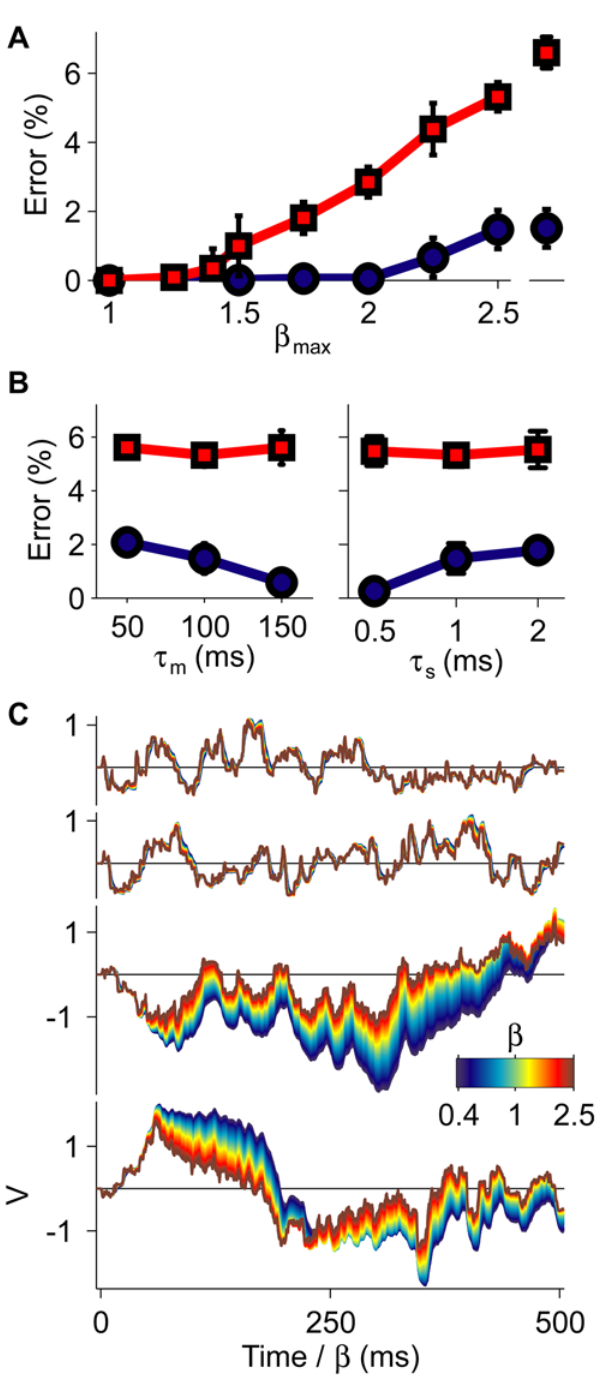
Figure 3. Classification of time-warped random latency pat- terns. (A) Error probabilities versus the scale of global time-warp b max for the conductance-based (blue) and the current-based (red) neurons. Errors were averaged over 20 realizations, error bars depict 6 1 standard deviation (s.d.). Isolated points on the right were obtained under dynamic time warp with b max =2.5 (see Materials and Methods). (B) Dependence of the error frequency at b max =2.5 on the resting membrane time constant t m (left) and the synaptic time constant t s (right). Colors and statistics as in (A). (C) Voltage traces of a conductance-based (top and second rows) and a current-based neuron (third and bottom rows). Each trace was computed under global time warp with a temporal scaling factor b (see Materials and Methods) (color bar) and plotted versus a common rescaled time axis. For each